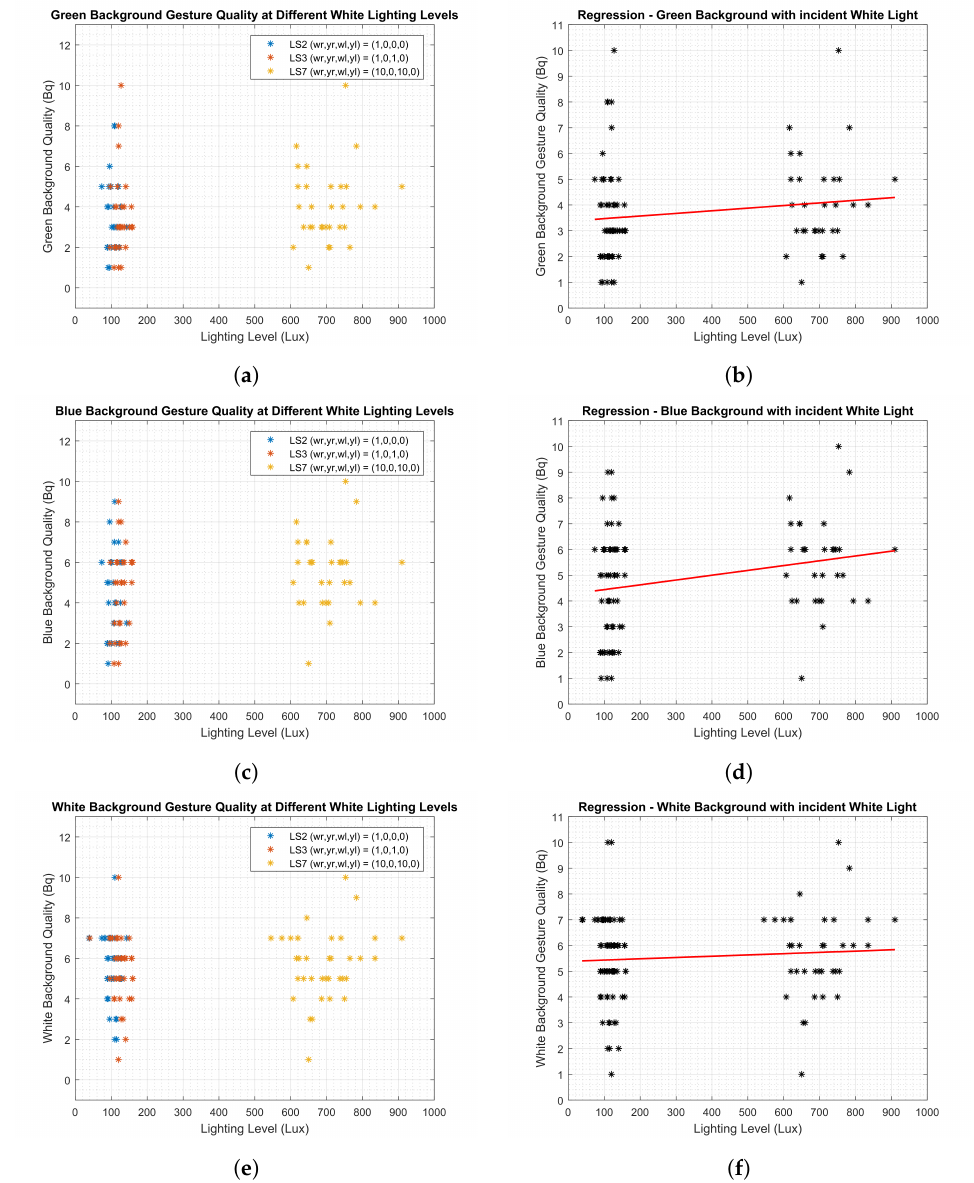
Figure 15. Varying Lighting Level (VLL) white incident LED light on green, blue, and white backgrounds. ( a ) VLL green background, ( b ) VLL green background regression, ( c ) VLL blue background, ( d ) VLL blue background regression, ( e ) VLL white background, ( f ) VLL white background